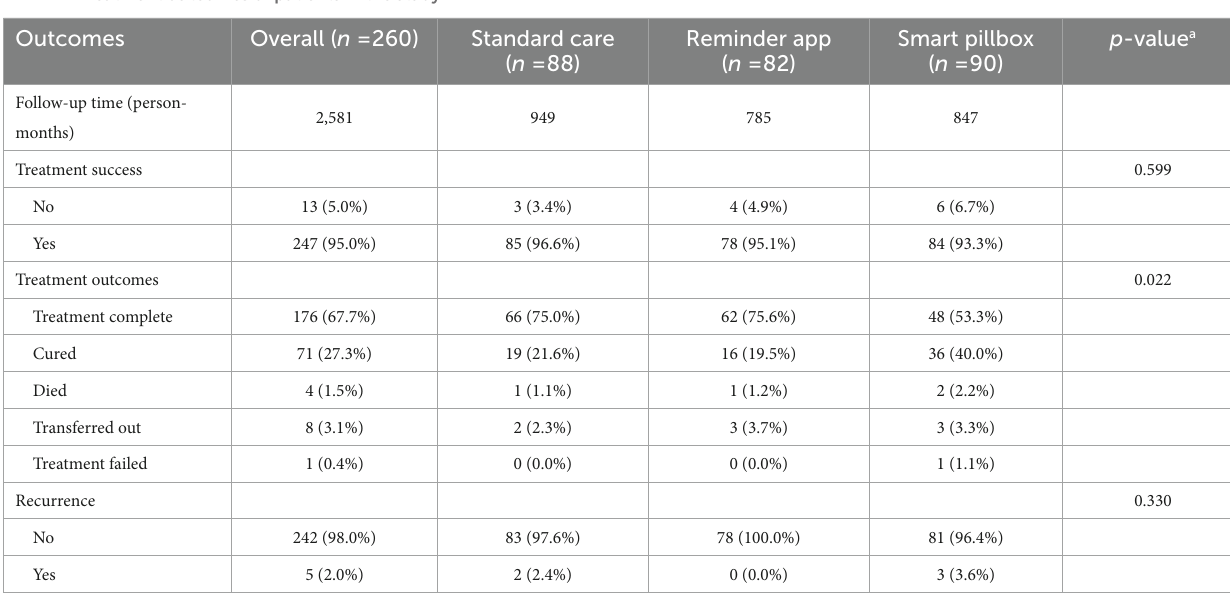
TABLE 2 Treatment outcomes of patients in the